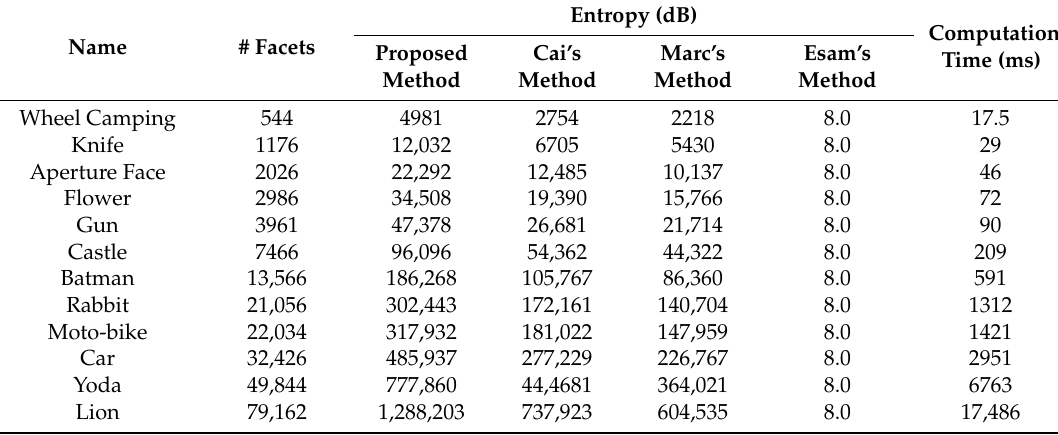
Table 1. Experimental